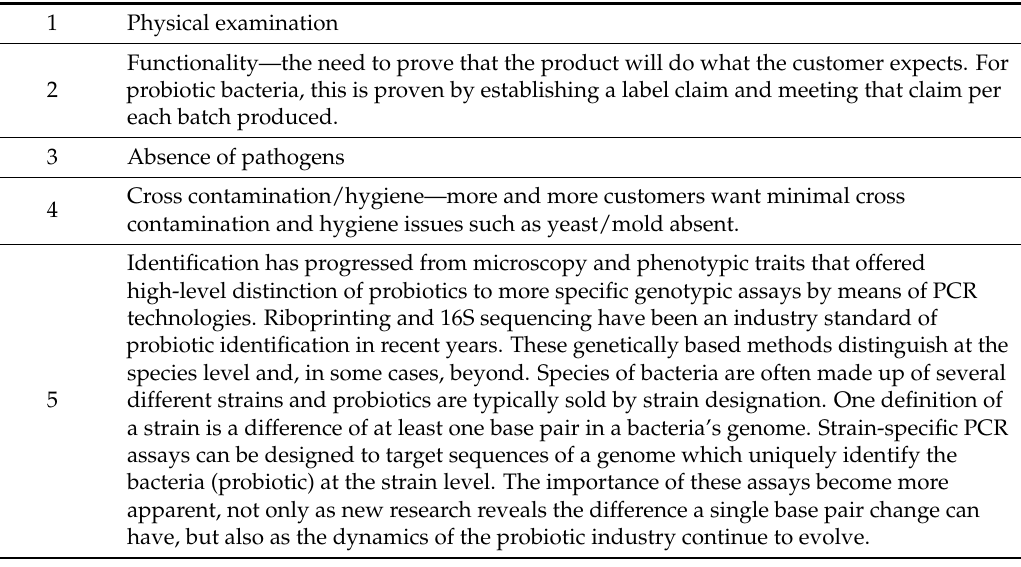
Table 4. Examples of end-product